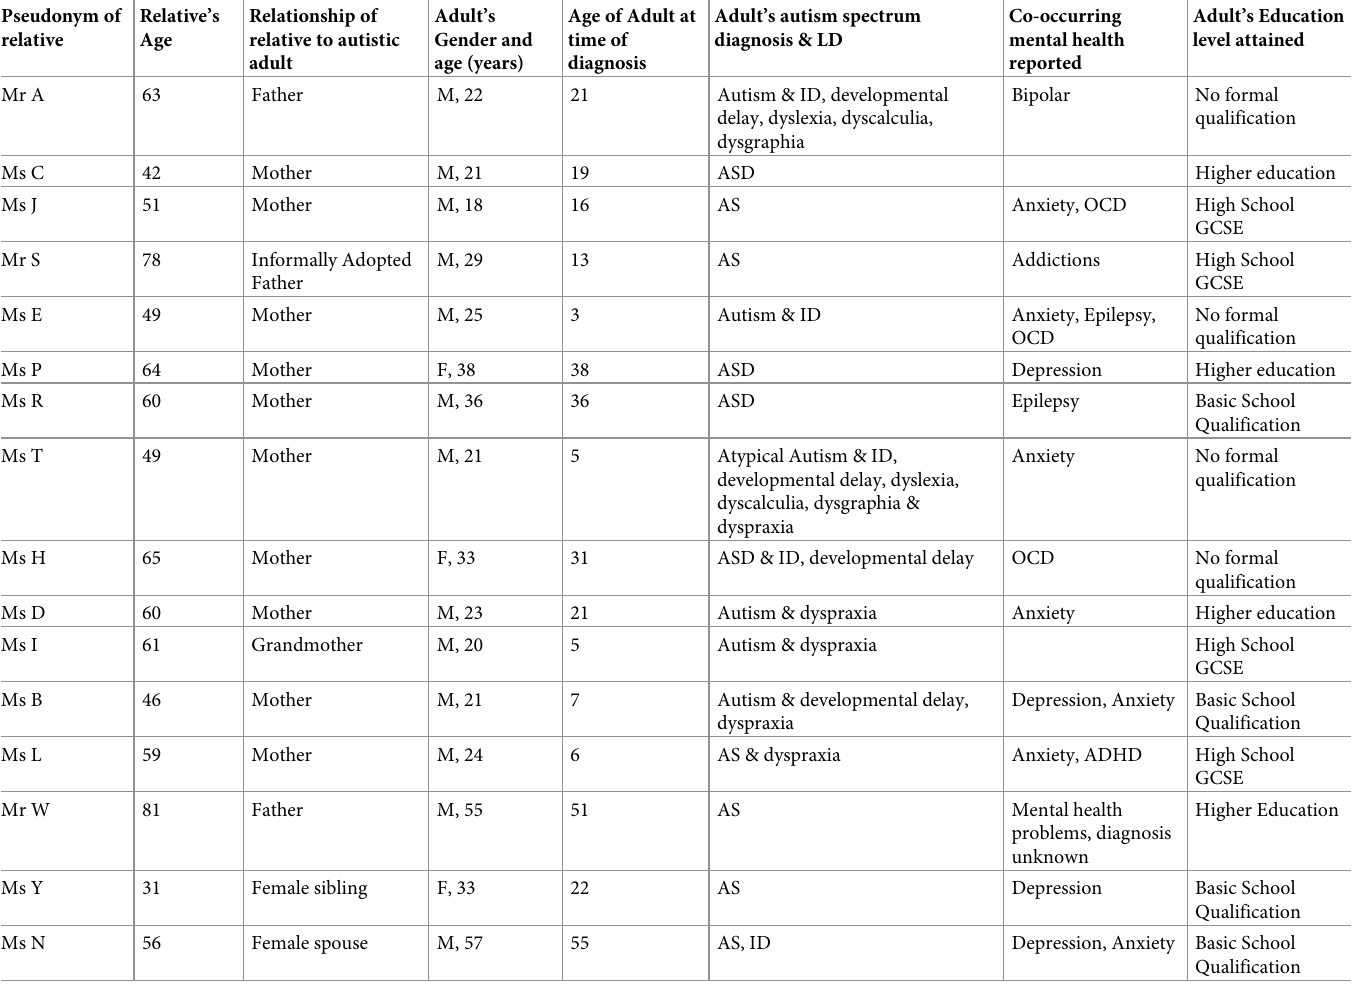
Table 2. Participant characteristics–relatives of autistic adults and autistic